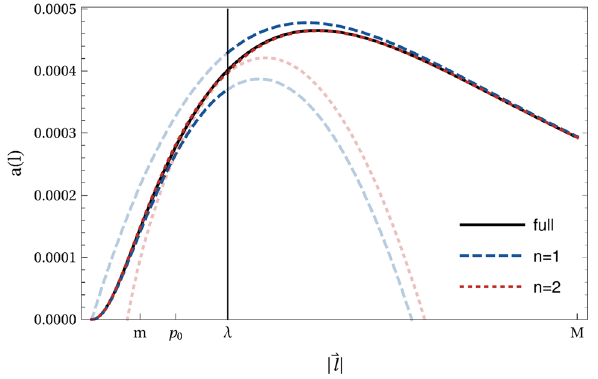
Fig. 3 The convergence at integrand-level of the expansion given in Eq. (38) for the values M = 10 m , p 2 = 3 m 2 , and μ UV = M